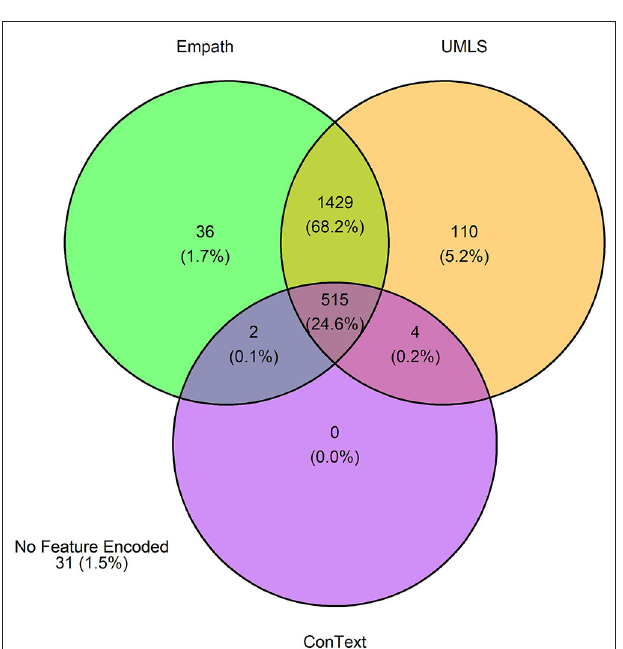
FIGURE 9 | Venn diagram depicting the number of annotations in the testing set encoded by each classifier.